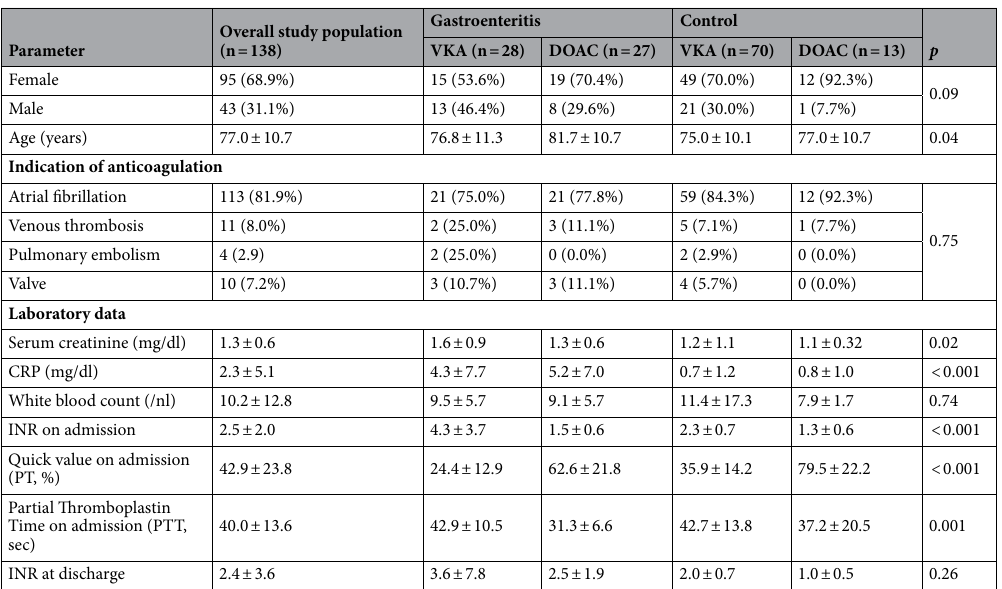
Table 1. Characterization of study population. Subjects with gastroenteritis versus subjects with hypertension serving as control group. Numeric data are presented as mean and standard deviation. Numeric data of the four groups were tested for statistically significant differences by ANOVA. Categorical data were compared by Pearson Chi squared test. p < 0.05 was regarded statistically significant. VKA vitamin K antagonist; DOAC direct-acting oral anticoagulants